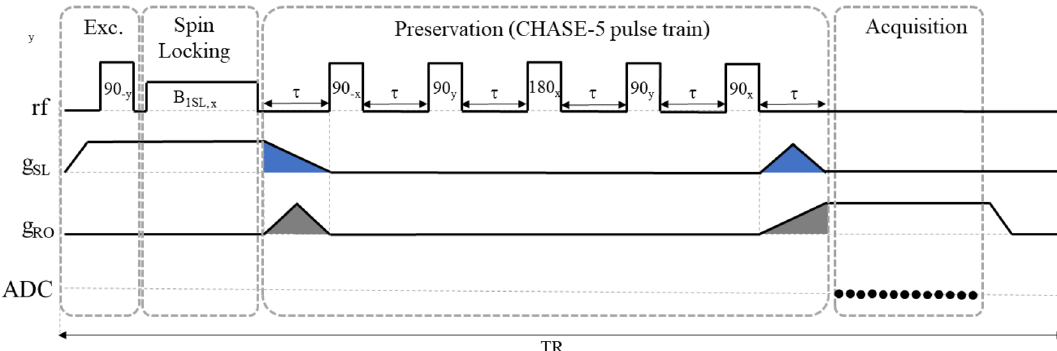
Image Sequence Fig.4(b)Left PETRA Fig.4(b)Right 3D-PreSLoP {150, 100, 100 } Fig.4(c)Left PETRA Fig.4(c) Middle 2D-PreSLoP Fig.4(c)Right 2D-DiSLoP Fig.5(b)Left PETRA Fig.5(b)Right 3D-PreSLoP {90, 60, 190 } 8 Fig.5(c)Left PETRA Fig.5(c) Middle 2D-PreSLoP {90, 60, 190 } 2 Fig.5(c)Right 2D-DiSLoP Fig.6(b)Left PETRA Fig.6(b)Right 2D-PreSLoP {180, 120, 550 } Fig.6(c)Up PETRA Fig.6(c) Down 3D-PreSLoP {90, 60, 500 }